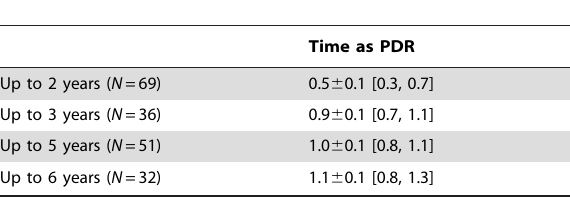
Table 3. PDRs research output in relation to the duration of postdoctoral employment: mean 6 standard error and 95% confidence interval